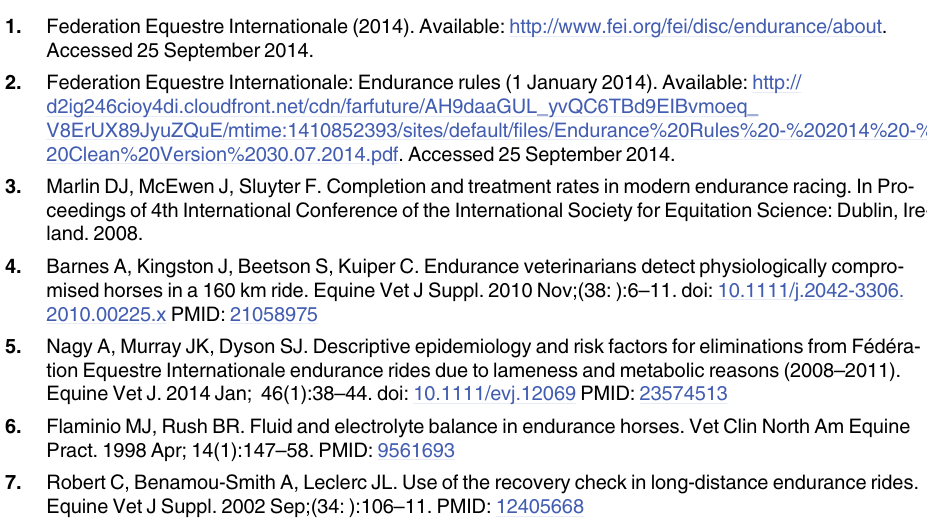
S1 Table. Total raw data including 7032 performance records used in the present study. S2 Table. Distribution of horses according to the number of starts, number of eliminations, reason for elimination, distance category and country. S3 Table. Mean (SD) shade temperature (°C) and relative humidity (%) in each country, for the month and the season during which the endurance event was organized. S4 Table. Results of the logistic regression, with an estimation of the probability of elimina- tion as a function of the event outcome and the reason for elimination at each vet gate (based on variables recorded at the previous vet